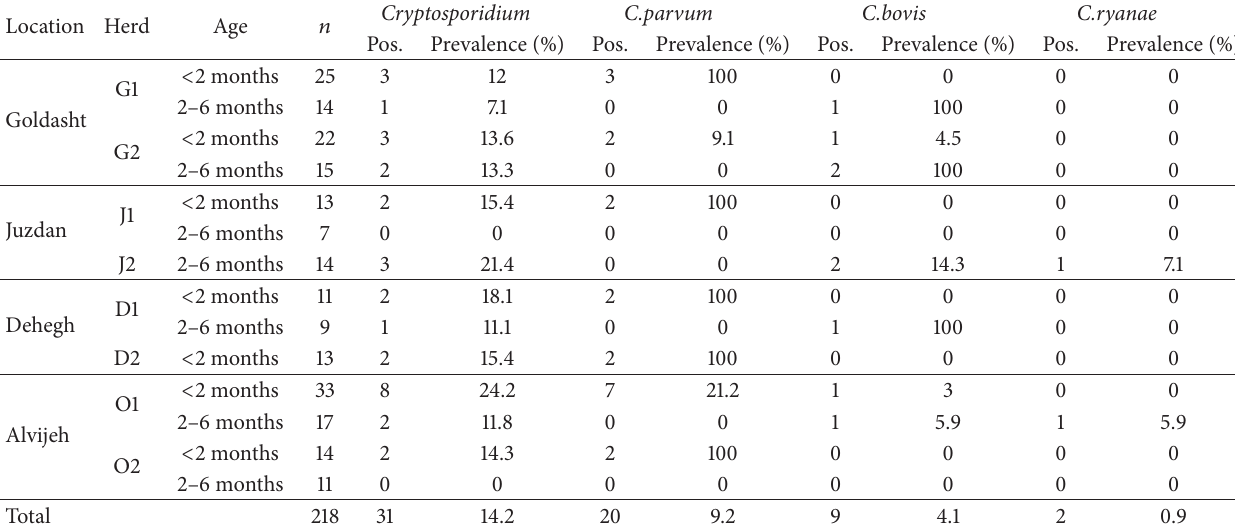
Table 4: Prevalence of Cryptosporidium and Cryptosporidium genotypes in the calves based on age. Location